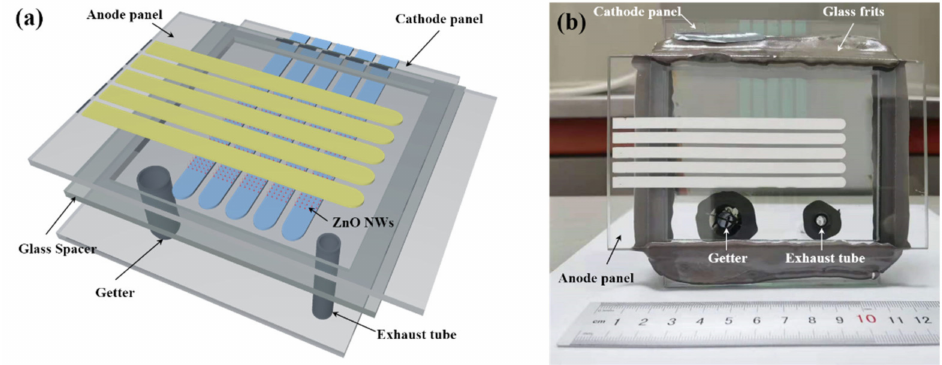
Figure 1. ( a ) Schematic diagram of the vacuum-sealed addressable diode-structure flat-panel X-ray source; ( b ) a picture of the fully vacuum-sealed addressable diode-structure flat-panel X-ray